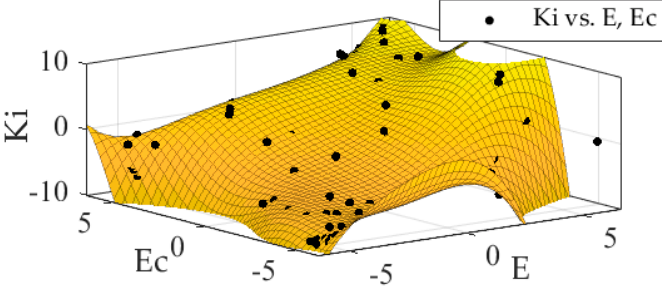
Figure 8. The fitting surface ΔK (cid:2926) of the granular function.